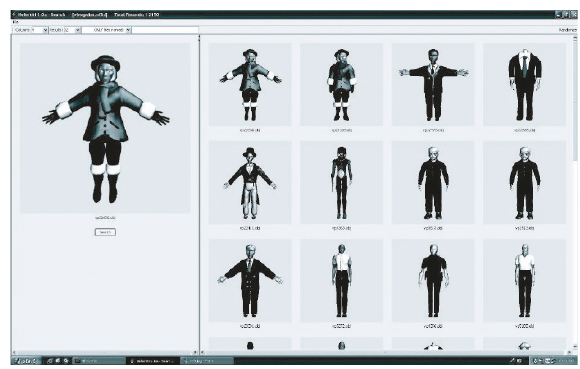
Figure 5: Retrieval of an animated 3D character. We retrieved all (i.e., 2) the postures associated with the mannequin and most of the human bodies from the 12 . 150 objects database. Only the first results are